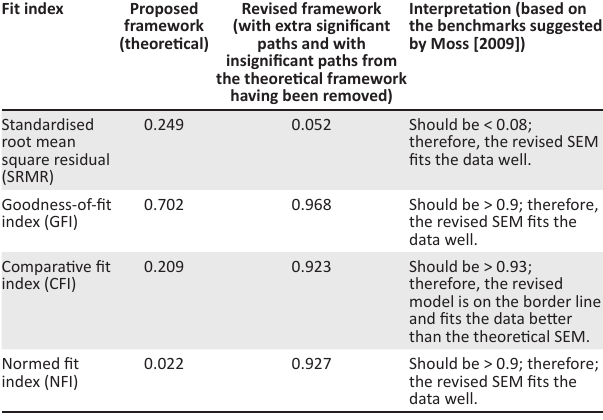
TABLE 2: Recommended benchmarks for structural equation